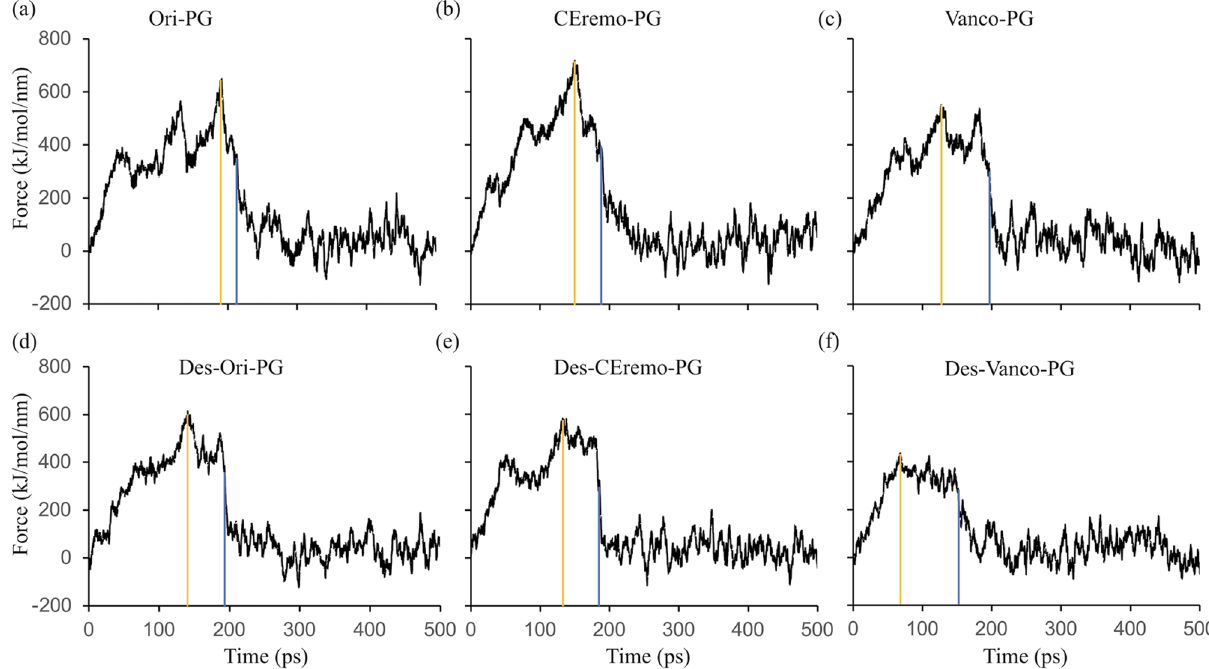
Figure 6. Plots of force vs time of the dissociation of the (desleucyl)glycopeptide and PG during center-of-mass (COM) pulling simulation. Plots of force vs time for ( a ) Ori–PG, ( b ) CEremo–PG, ( c ) Vanco–PG, ( d ) Des- Ori–PG, ( e ) Des-CEremo–PG, and ( f ) Des-Vanco–PG complexes. The yellow line in each figure corresponds to the point of maximum force and the blue line represents a major dissociation point between the (desleucyl) glycopeptide and PG.